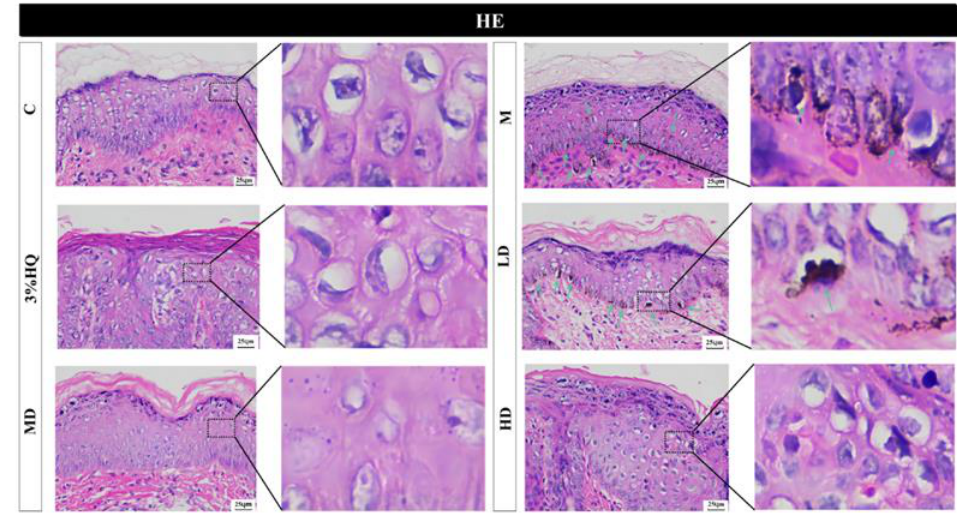
Figure 5. Effects of AA on histopathological features of dorsal skin. H&E staining green arrow indicates the melanin. C mean control group, M mean model group, 3% HQ mean 3% hydroquinone cream group, LD mean low dose group, MD mean medium dose group, and HD mean high dose group. ( n = 6 per group).